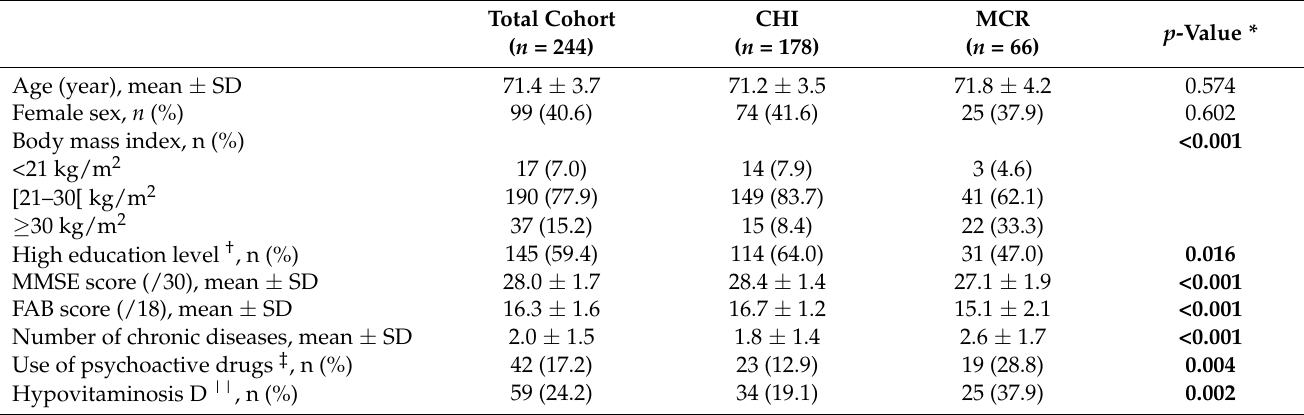
Table 2. Characteristics and comparison according to the MCR syndrome ( n =